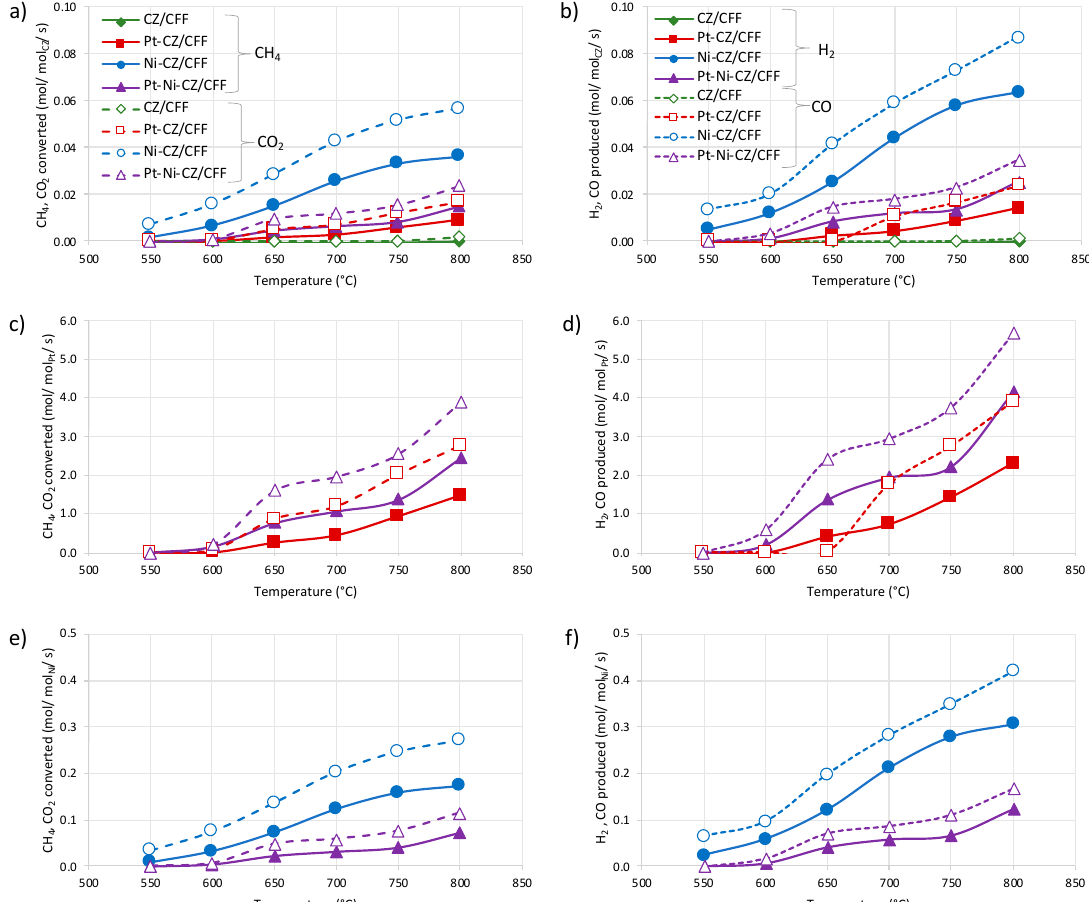
Figure 10. The comparison of the rates of CH 4 and CO 2 conversions ( a , c , e ), and H 2 and CO productions ( b , d , f ) over CZ, Pt and Ni active sites in CFF-supported catalysts during DRM tests in isothermal conditions. Reaction mixture: 4 vol. % CH 4 , 10 vol. % CO 2 , balanced with Ar. GHSV = 5000 h − 1 . TOS = 2 h.